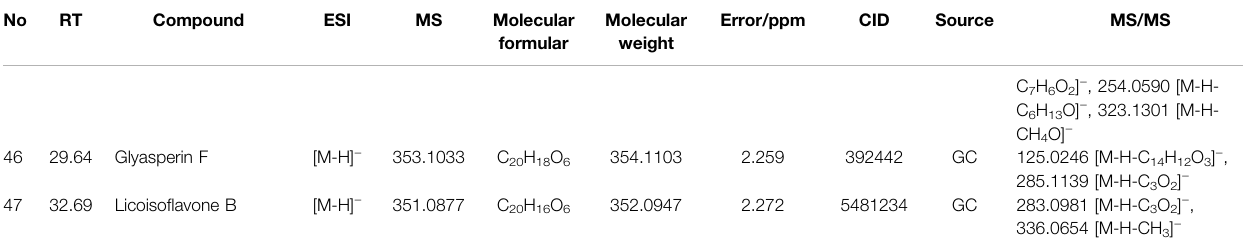
TABLE 1 | ( Continued ) Identi fi ed compounds of QFLT by